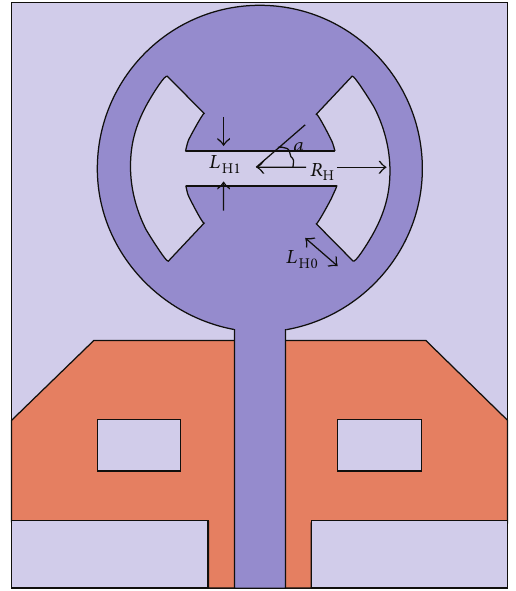
Figure 3: Geometry of the arc H-shaped